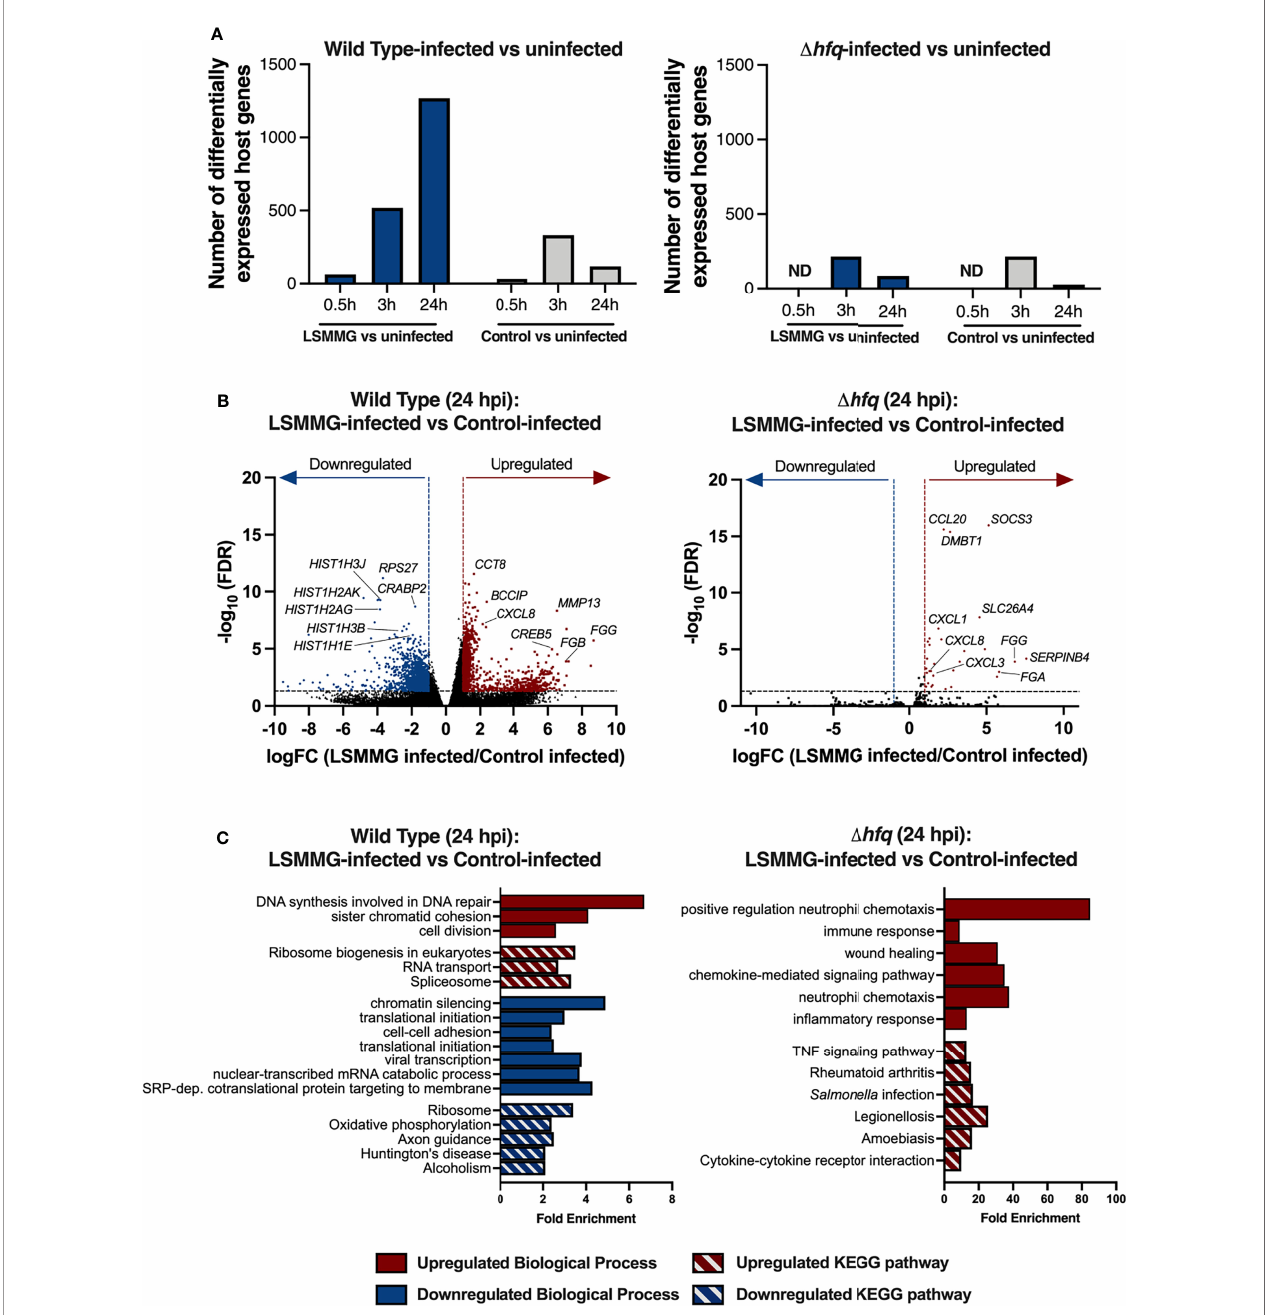
FIGURE 5 | Response of 3-D co-culture model to infection with LSMMG- or control-cultured S . Typhimurium. (A) Number of differentially regulated transcripts between infected and uninfected host cells. Differentially expressed genes were determined by log 2 fold change (logFC) cut-off of at least ± 1 and FDR < 0.05. Blue columns indicate differentially regulated transcripts in LSMMG-infected host cells relative to uninfected cells and gray columns indicate control-infected host cells relative to uninfected cells. ND indicates not determined. (B) Volcano plots of host transcriptional changes at 24 hours post-infection. Differentially expressed genes between LSMMG-infected versus control-uninfected host cells for the wild type (left panel) or hfq mutant (right panel) are shown. Red: signi fi cantly upregulated genes during LSMMG infection. Blue: signi fi cantly downregulated genes during LSMMG infection. Signi fi cance determined according to a logFC in expression of at least ± 1 and FDR <0.05. (C) Enriched GO Biological Processes and KEGG pathways for LSMMG-infected versus control- infected host cells at 24 hpi. Analysis was performed in DAVID 6.8 using upregulated (red) or downregulated (blue) transcripts using an EASE score of 0.05 and Benjamini-Hochberg correction to determine signi fi cantly enriched terms and pathways (adjusted P < 0.05). Red bars indicate upregulated biological processes (solid) or KEGG pathway (hatch). Blue bars indicate downregulated biological processes (solid) or KEGG pathway